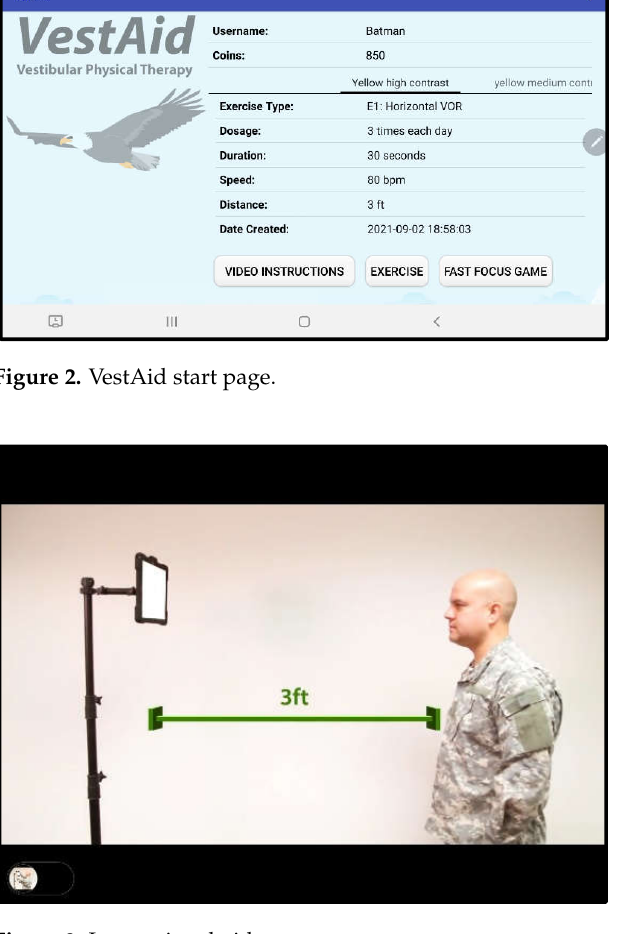
Figure 4. Pre-exercise symptom rating page.